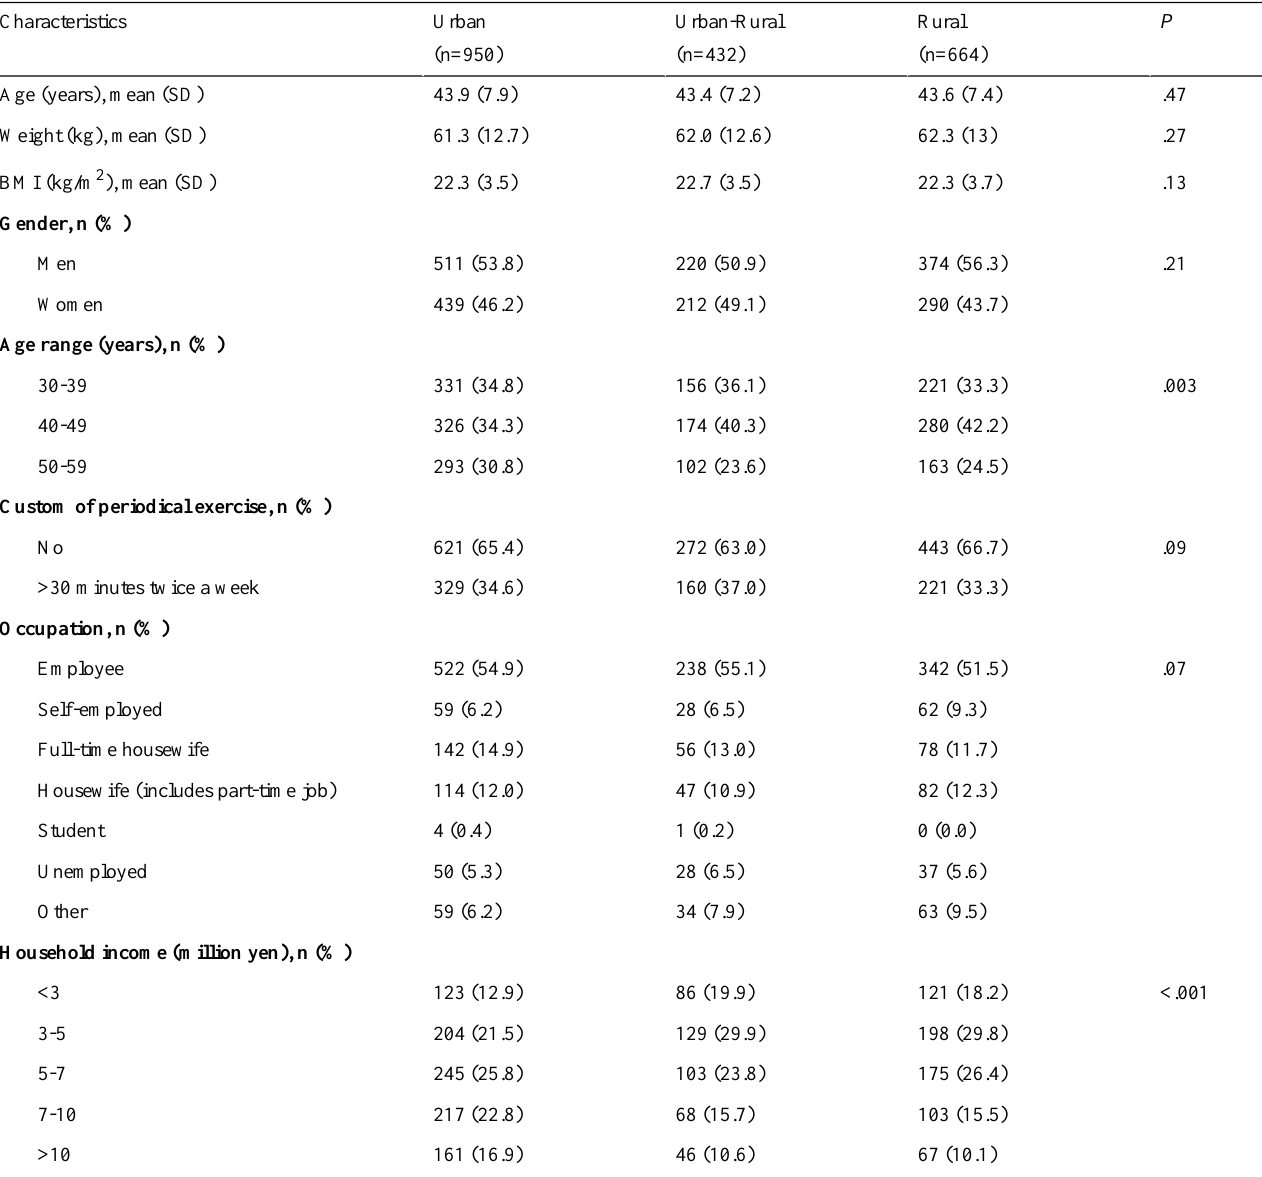
Table 1. Characteristics of the study population